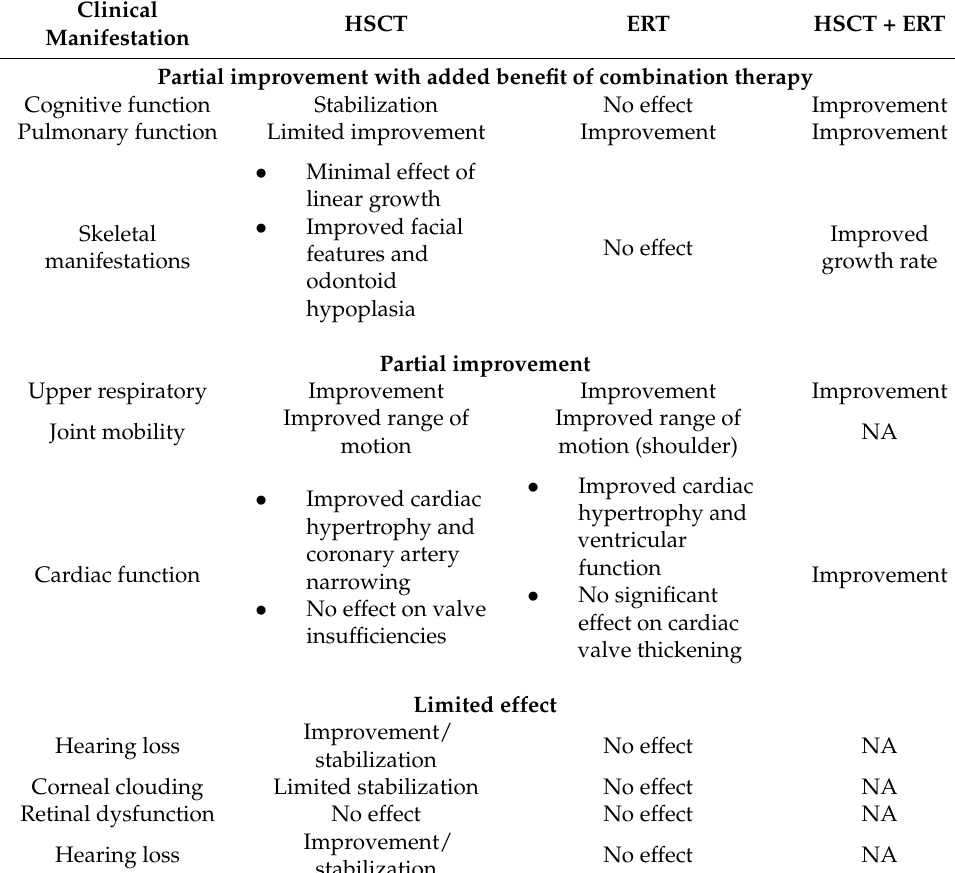
Table 1. Effect of HSCT and ERT on clinical manifestations in MPS